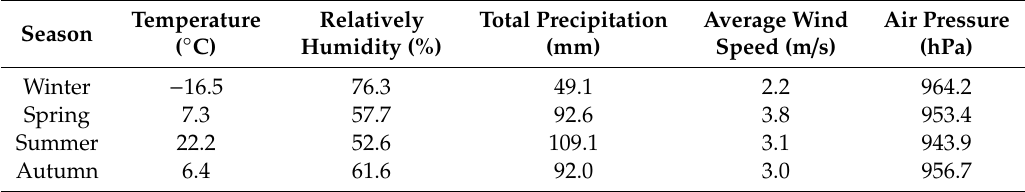
Figure 1. Location of the study area (the red star represents Akedala Station). Table 1. The seasonal meteorological parameters from January 2017 to December 2019 in